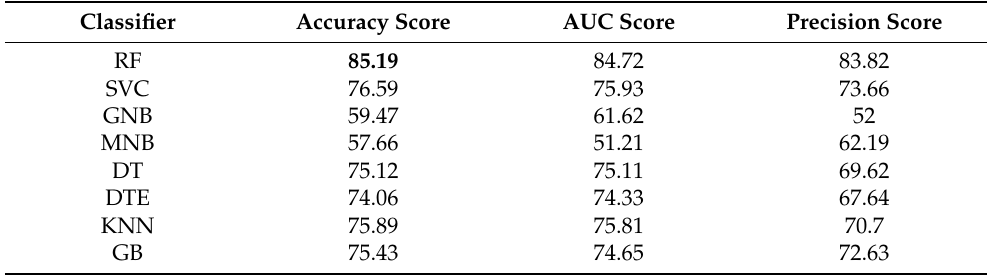
Table 2. Overall statistics of the accuracy assessment results of machine learning algorithms.